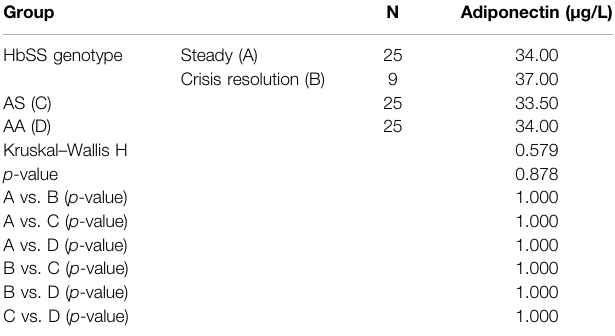
TABLE 2 | Levels of Adiponectin in different hemoglobin phenotype groups. Group N